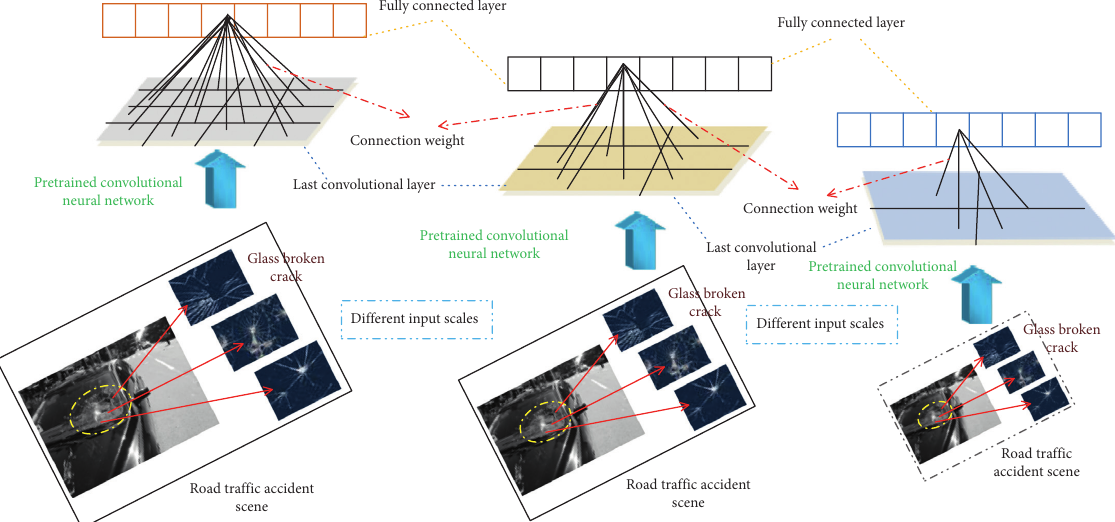
Figure 3: CNN output at different image scales.